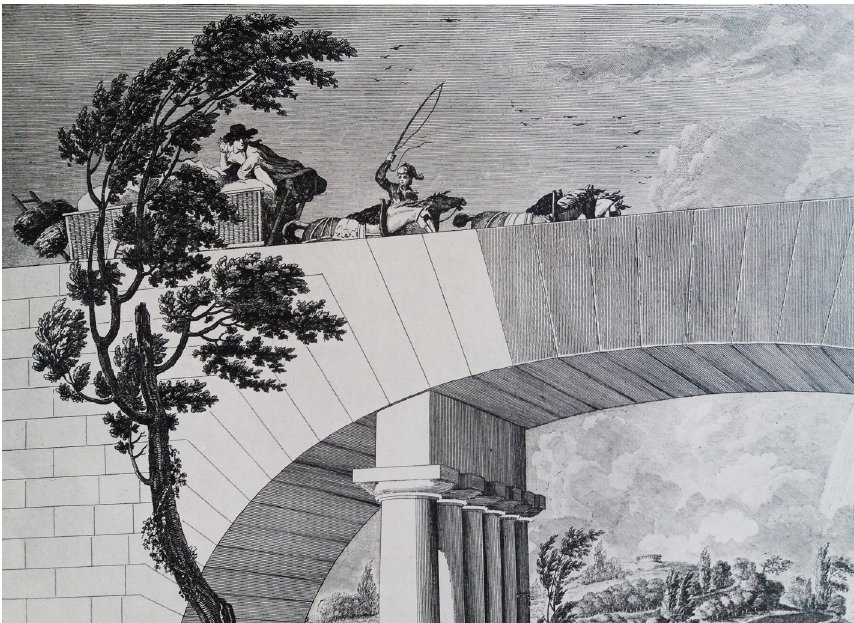
Claude-Nicolas Ledoux, “abreu- voir et lavoir de